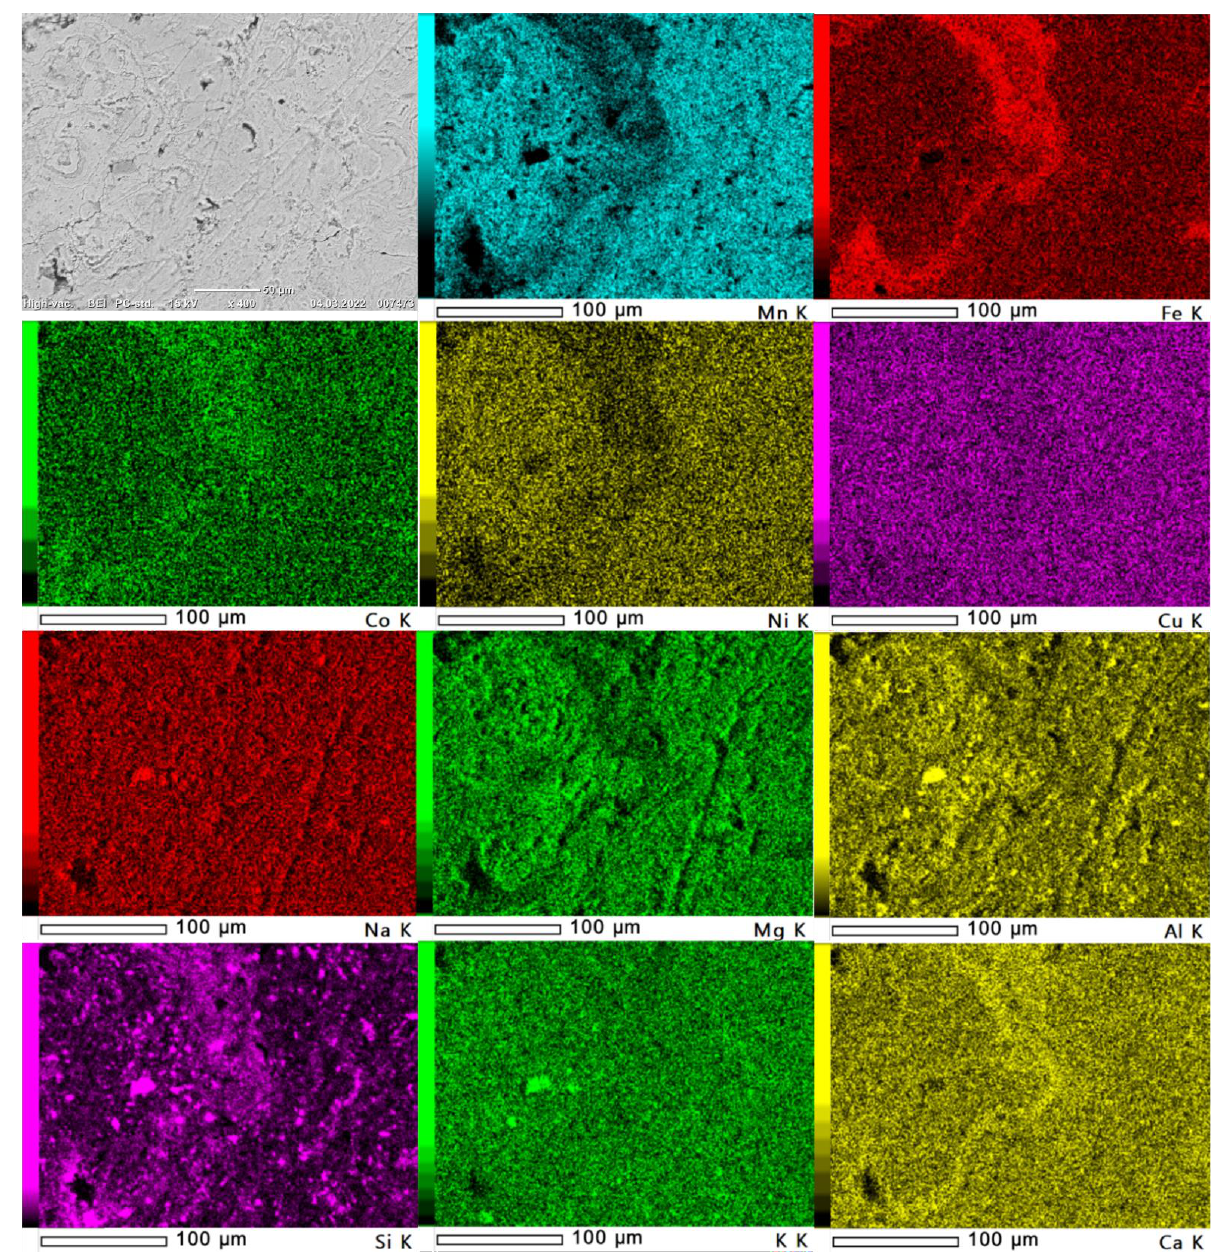
Figure 4. SEM-BEI image of the raw ore and elemental distribution mapping by EDS of the same area.